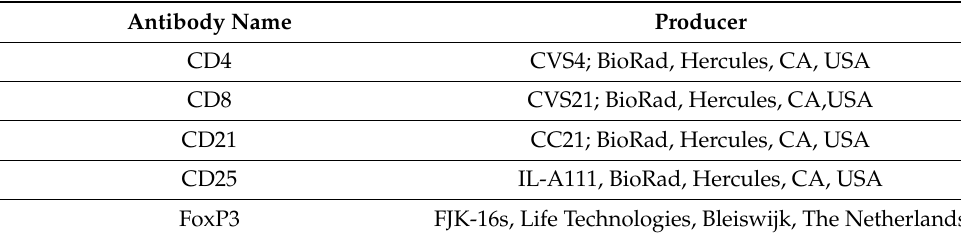
Table 2. Oligonucleotide sequences used for real-time PCR. GAPDH—Glyceraldehyde